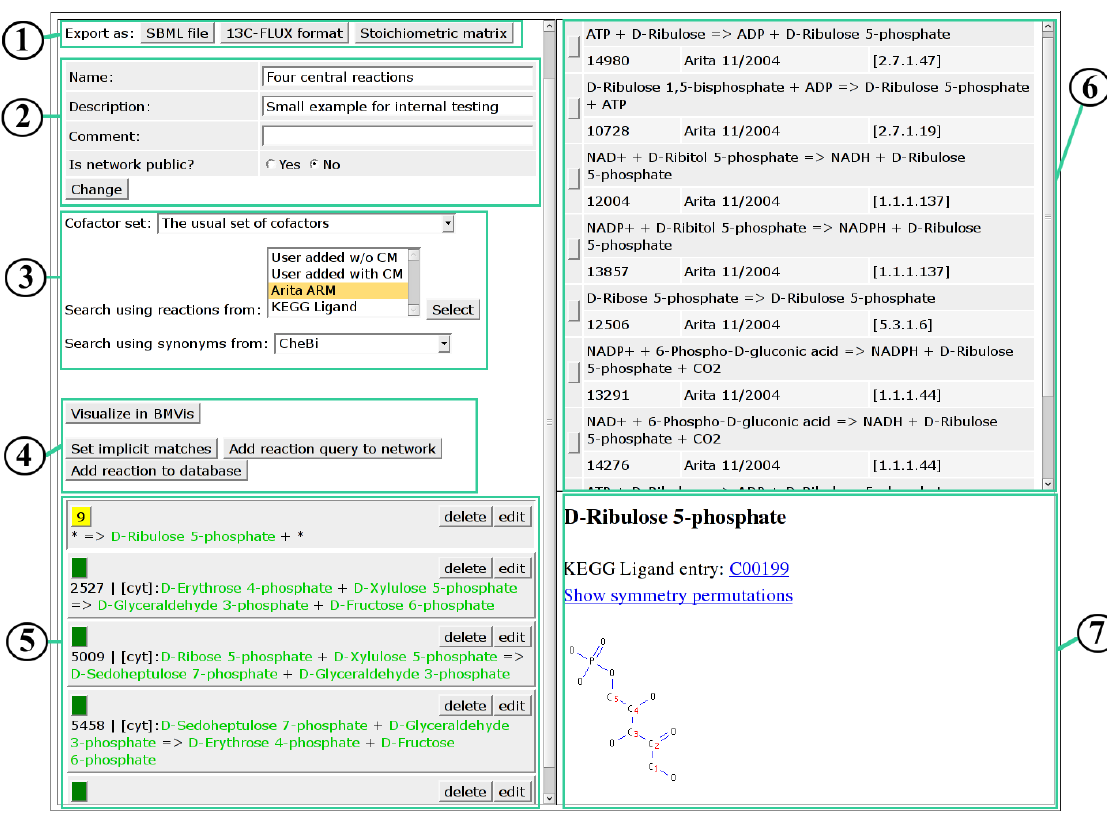
Figure 4: ReMatch reaction list view, showing model export options (1), model description (2), data source options (3), access buttons for visualising the model and adding reactions to the model (4), model reactions (5), candidate reactions for the selected reaction equation (6), and finally the molecular structure of a particular reactant, namely D-Ribulose 5-phosphate